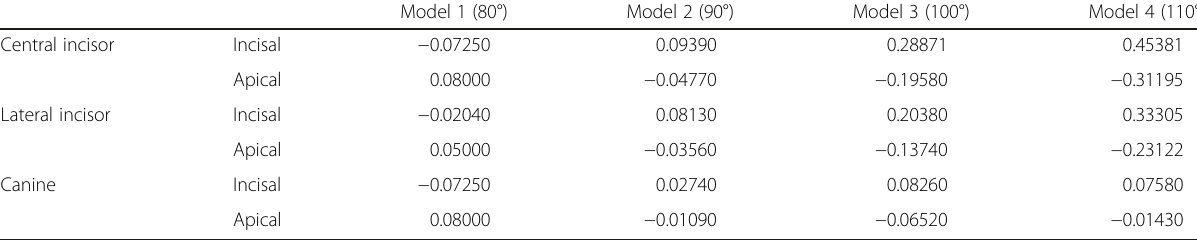
Table 2 The incisal and apical displacements of the anterior teeth in various models